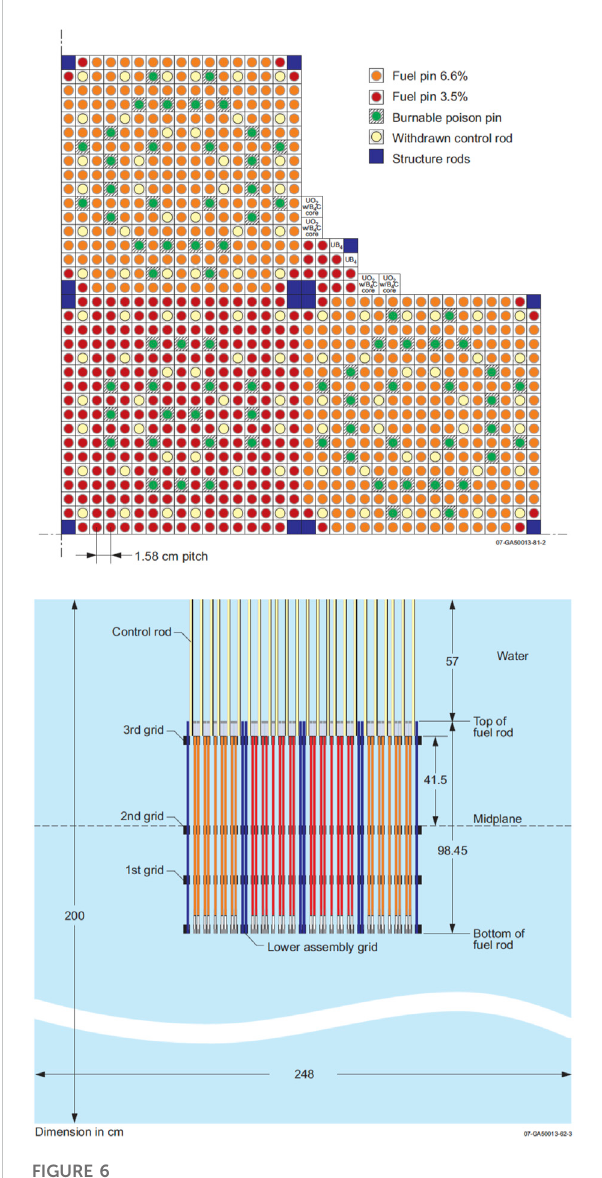
Quarter-coreTopview(Top)andsideview(Bottom)ofottohahn reactor core benchmark model.